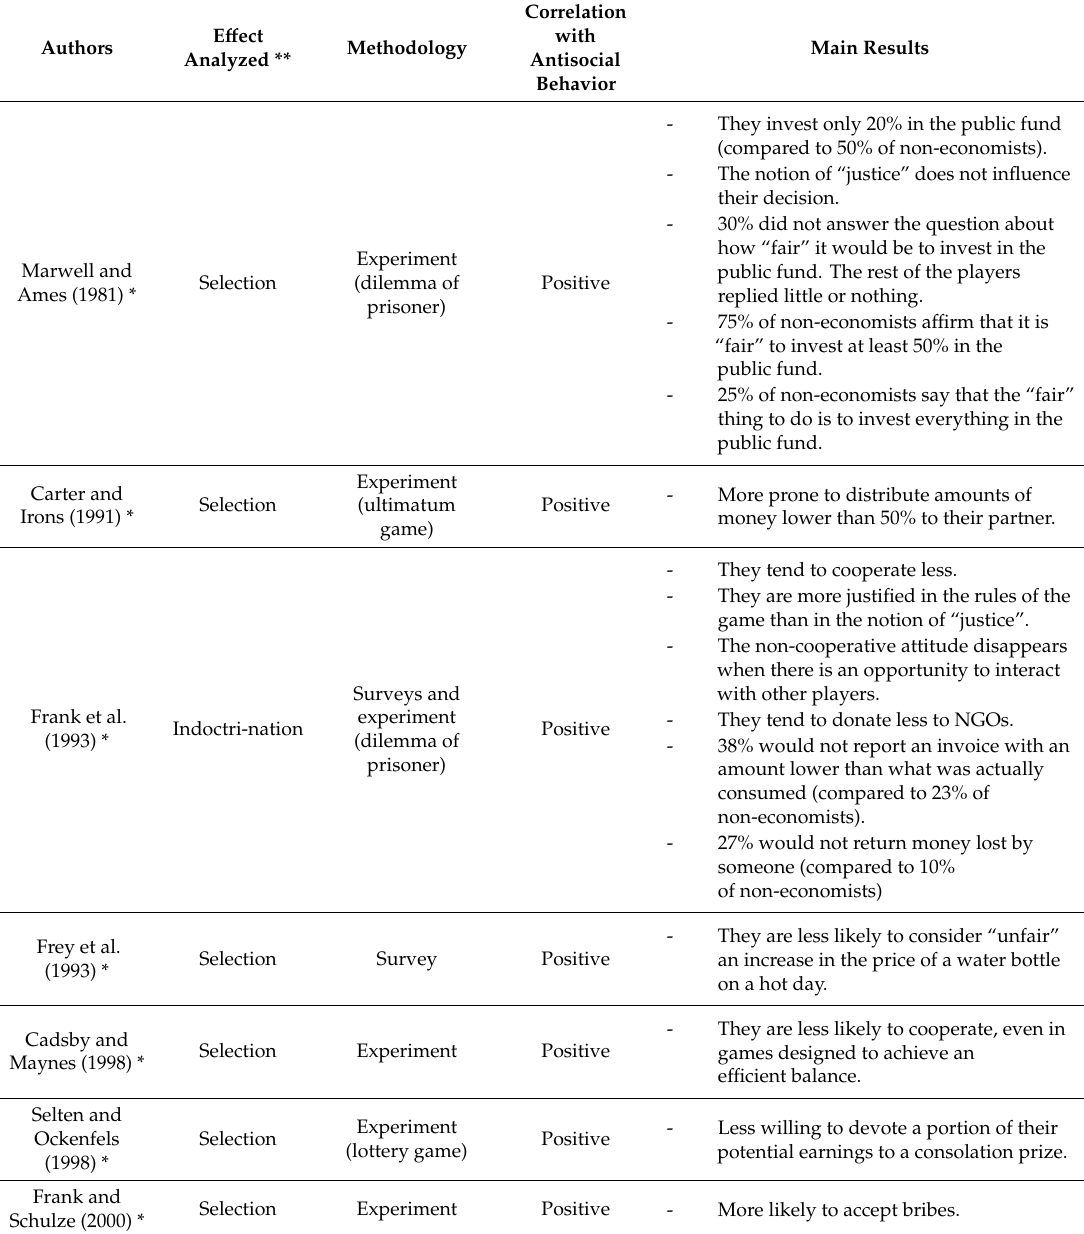
Table 1. Evidence on antisocial and immoral behaviors by students of (neoclassical)